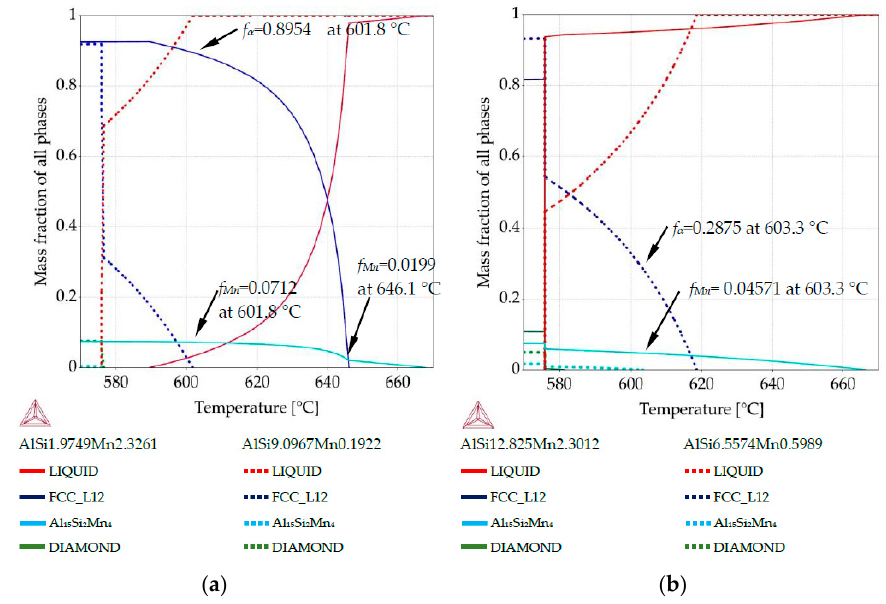
Figure 7. Property diagrams: ( a ) property diagram for AlSi5Mn1.0 specimen, for places with chemical composition AlSi1.97Mn2.32 and AlSi9.09Mn0.19; ( b ) property diagram for AlSi7Mn1.0 specimen, for places with chemical composition AlSi12.82Mn2.30 and AlSi6.55Mn0.59.